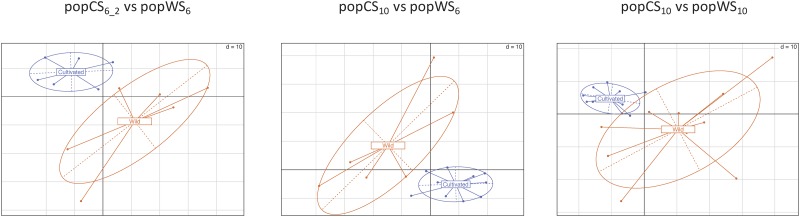
Cultivated and wild type sorghum sample 2D projection using a PCA of their eT-ratios.Each sorghum accession, associated with eT-ratios, can be seen as a point in a high dimensional space. This figure displays the projection of these points on the two first PCA axes using orange /blue dots to represent wild /cultivated individuals. The two first axes explain more than 30% of the original variability in all three cases.